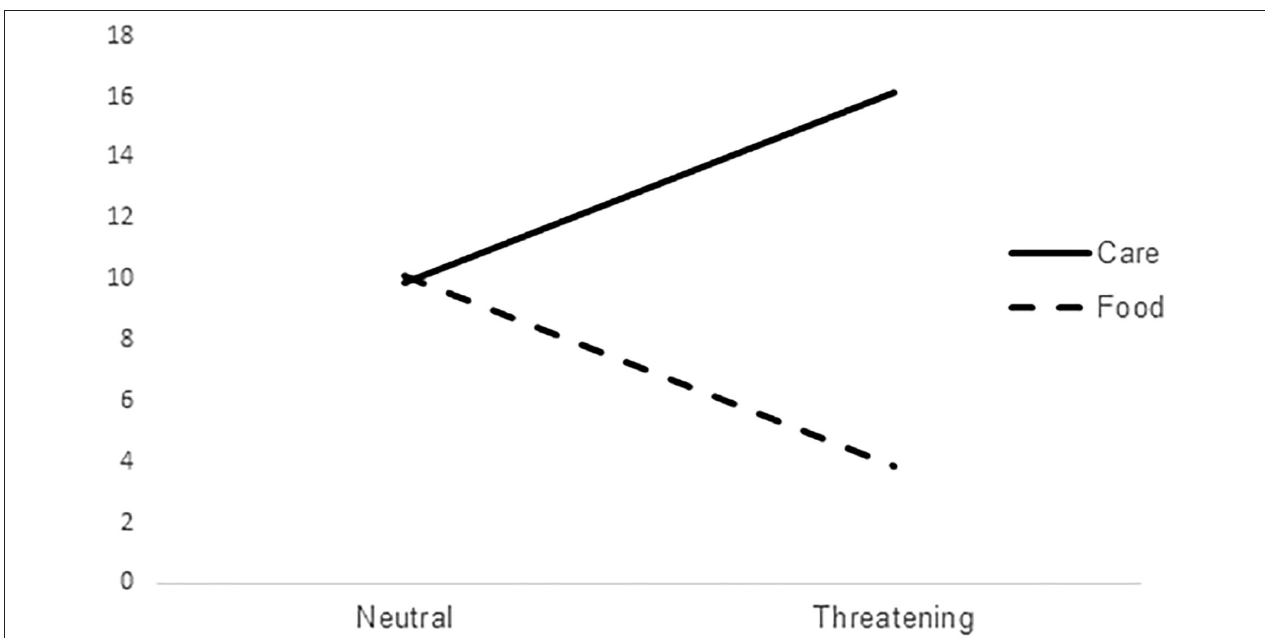
FIGURE 1 | Means of care and food choices in the two